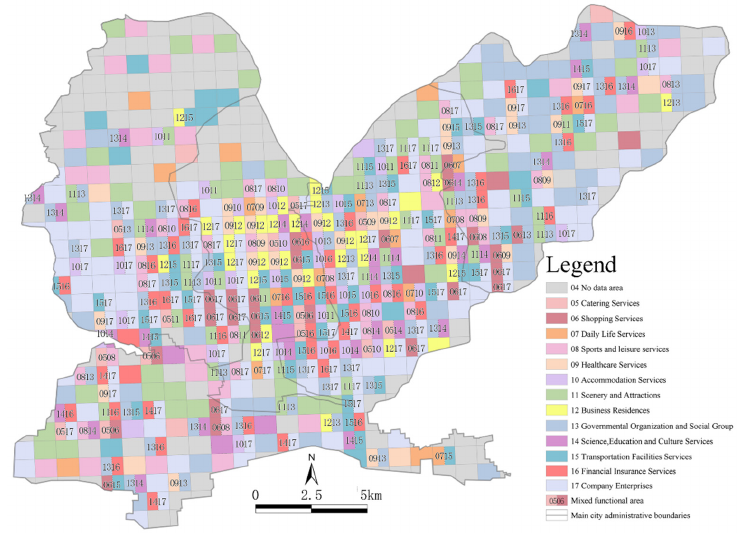
Figure 7. The distribution of urban functional units in the main urban area in Jiaozuo.